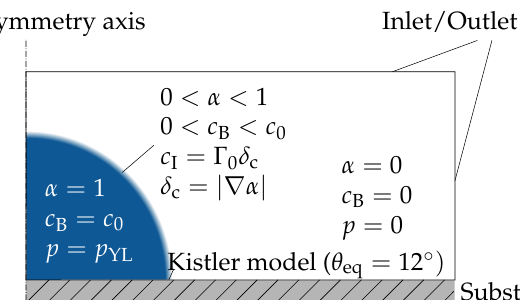
Figure 2. Domain with initial and boundary conditions for droplet spreading